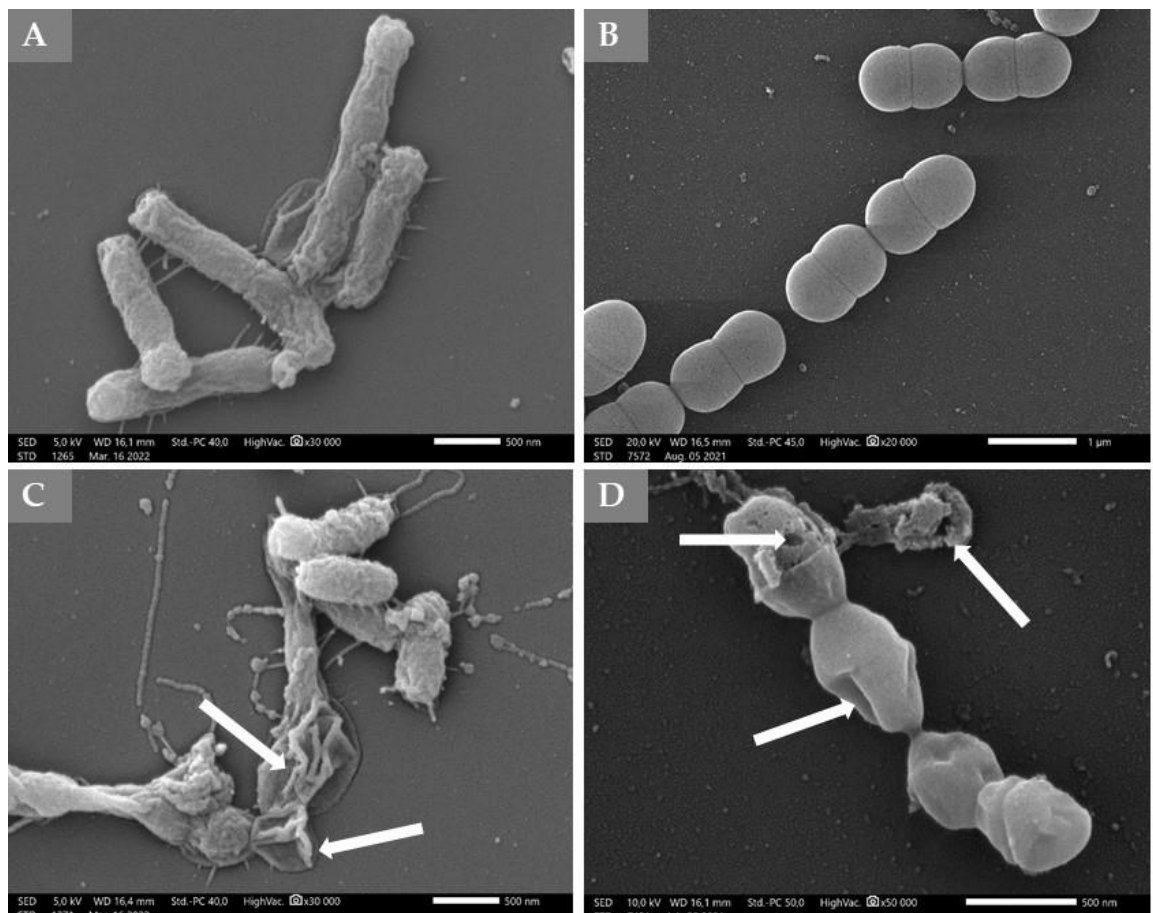
Figure 3. Micrograph—Scanning electron microscopic images of H. parainfluenzae and S. pneumoniae treated by immortelle EO. ( A ): Untreated control of H. parainfluenzae , ( B ): Untreated control of S. pneumoniae cells. ( C ): Treated sample of H. parainfluenzae , ( D ): Treated sample of S. pneumoniae . Immortelle EO was used in MIC × 2 concentration. The arrows show the malformed and burst cells.